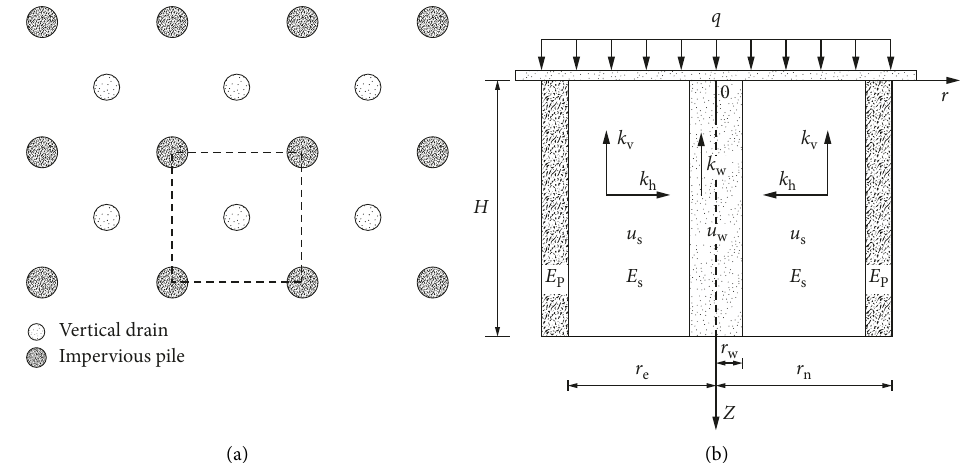
Figure 1: Vertical drain-impervious pile multicomposite foundation consolidation model. (a)Layout plan. (b)Cutaway